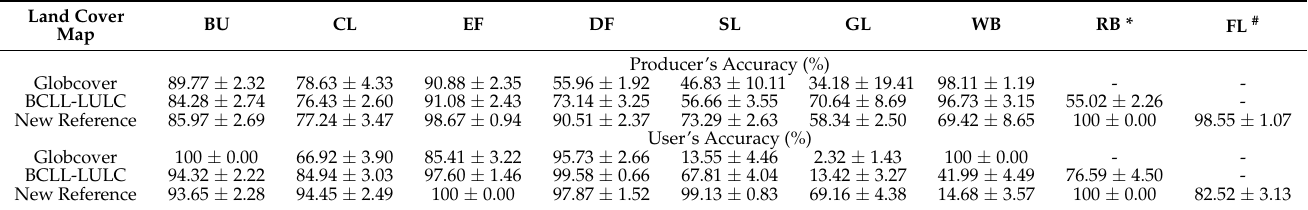
Table 3. Average producer and user accuracies of GlobCover, Biodiversity Characterization at Landscape Level (BCLL)-Land Use and Land Cover (LULC), new reference map, validated using test sample of 100 pixels per class. The corresponding standard deviation of accuracie values are indicated based on the variations during 100 trials (BU—Built-Up, CL—Cropland, EF—Evergreen Forest, DF—Deciduous Forest, SL—Shrubland, GL—Grassland, WB—Water Bed, RB—River Bed, FL— Fallow Land).